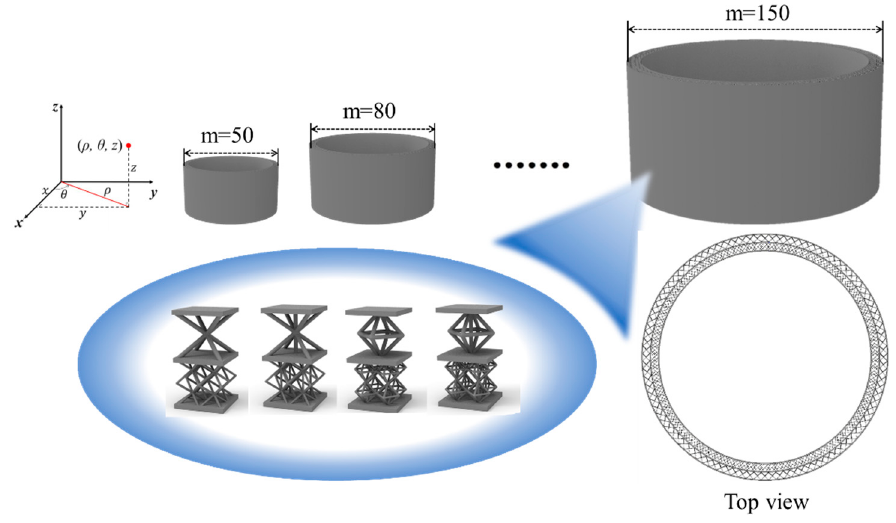
Figure 14. Model of Bi-layer lattice sandwich cylinder structure by different lattice cells.